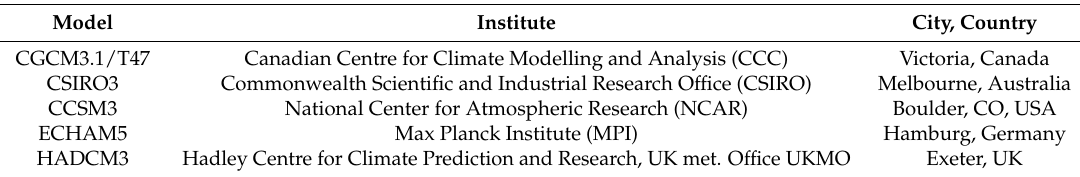
Table 3. List of selected GCMs (AR4, 2007) used in this study